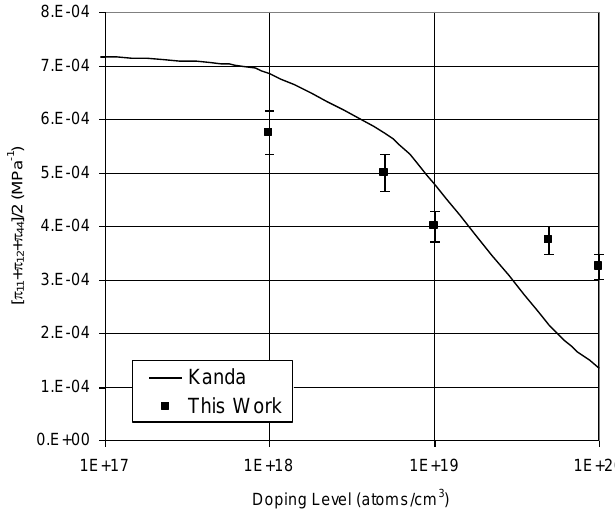
and Kanda’s model [23] at 44